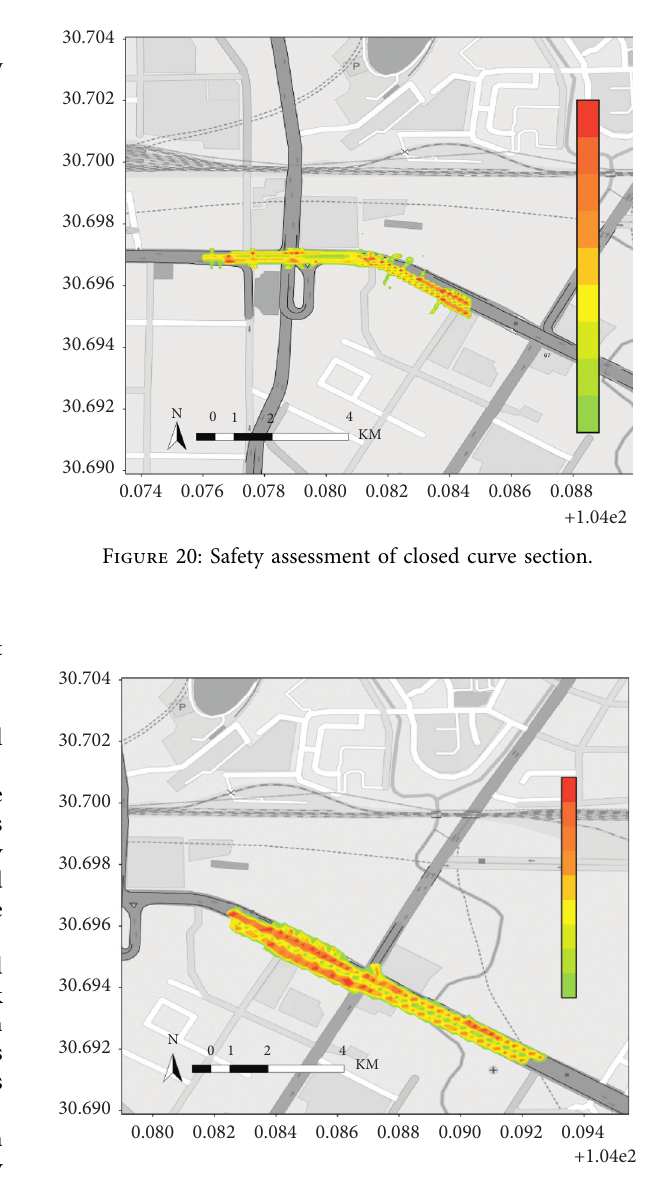
Figure 21: Safety assessment of vehicle entry section and vehicle exit